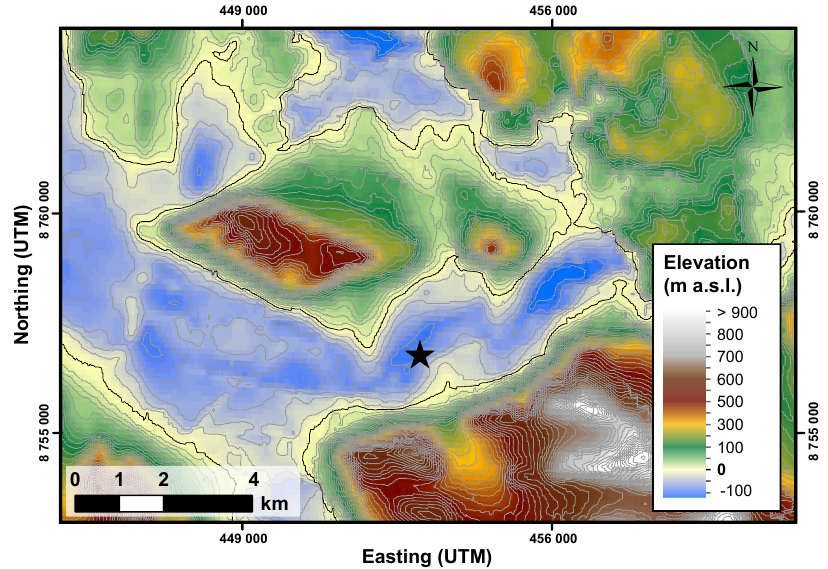
Figure 6. Subglacial, bathymetric, and land elevation of Kronebreen at 50m gridded resolution with 20m elevation contours. Location of the borehole study is marked with a black star (How et al., 2017). Grid projection is Universal Transverse Mercator Zone 33W.